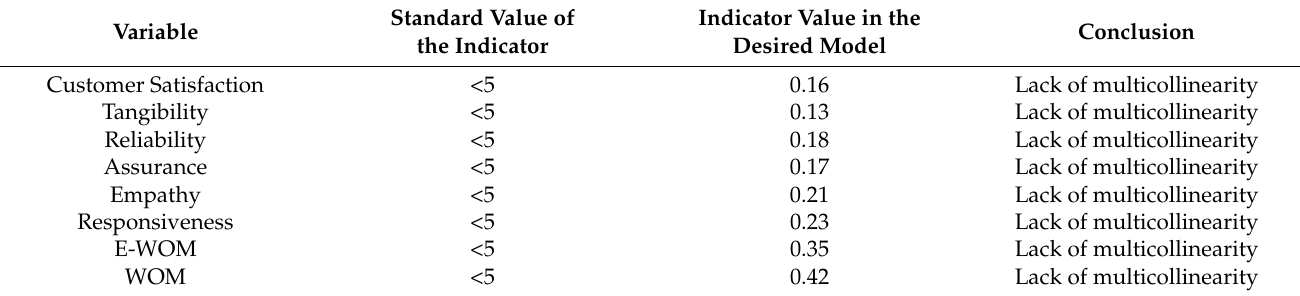
Table 1. Collinearity